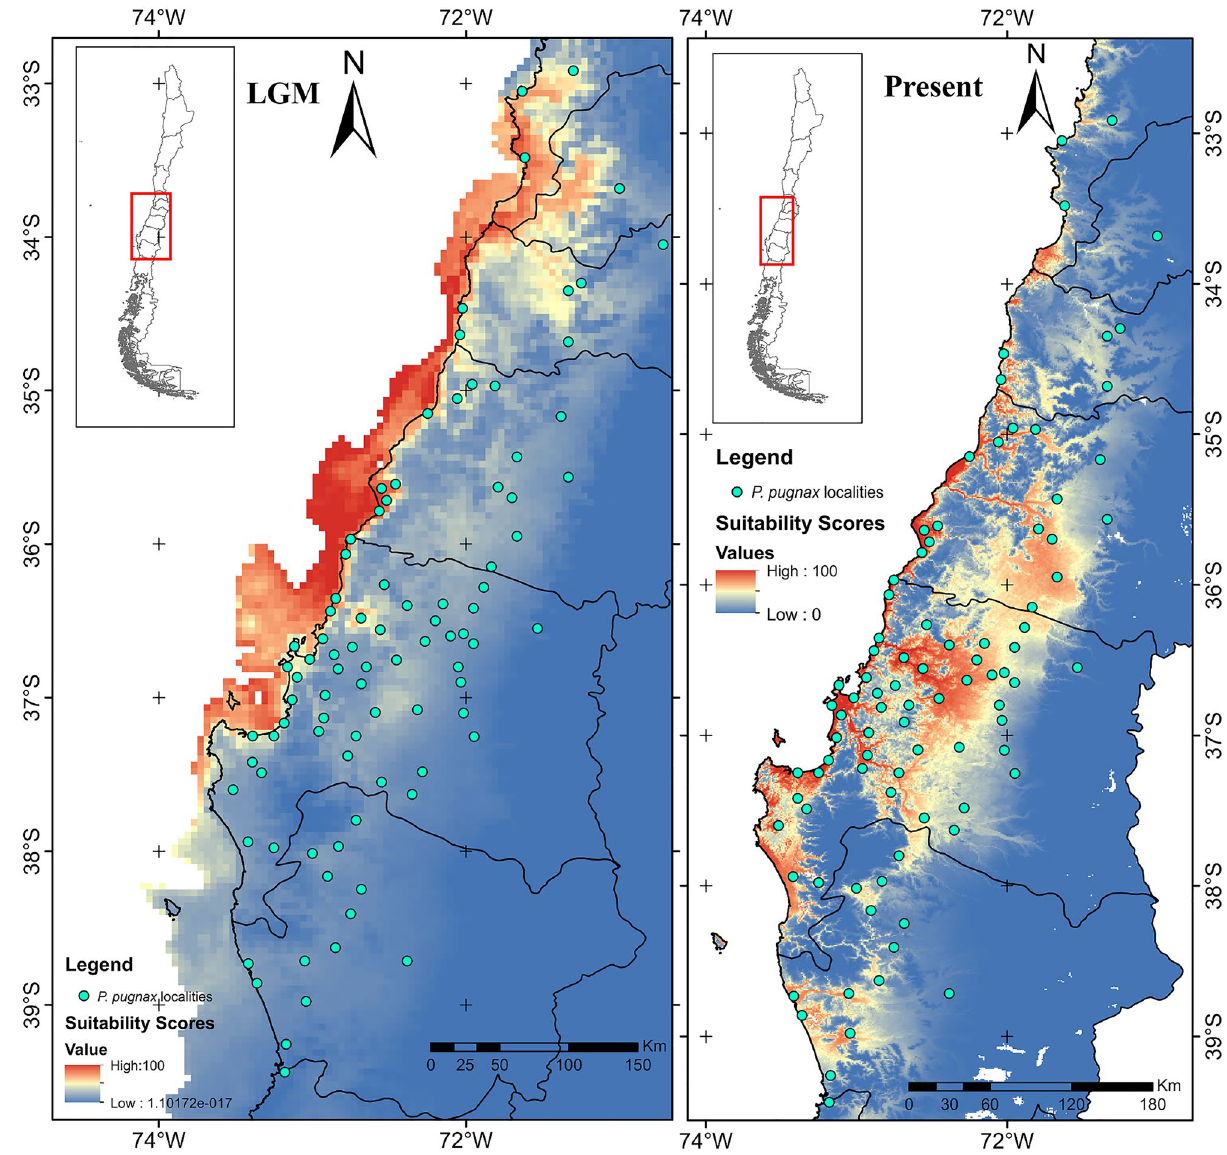
Figure 6. Habitat suitability map for Parastacus pugnax during the Last Glacial Maximum (LGM) and the present. The model and maps were generated with the software MaxEnt v.3.3.3e 75 (http:// biodi versi tyinf ormat ics. amnh. org/ open_ source/